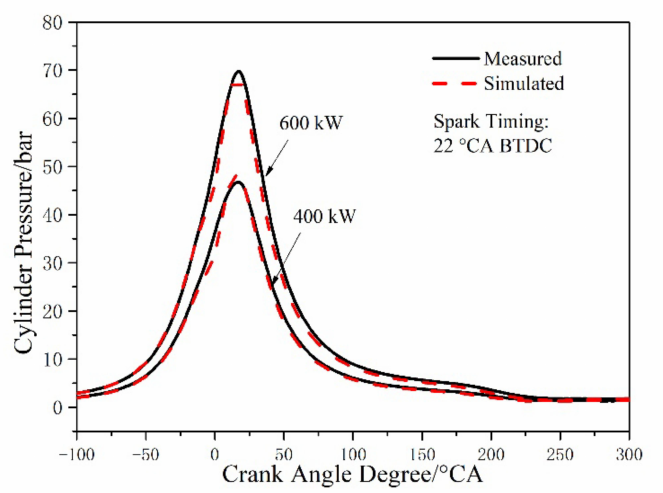
Figure 5. Comparison of the simulated and measured cylinder